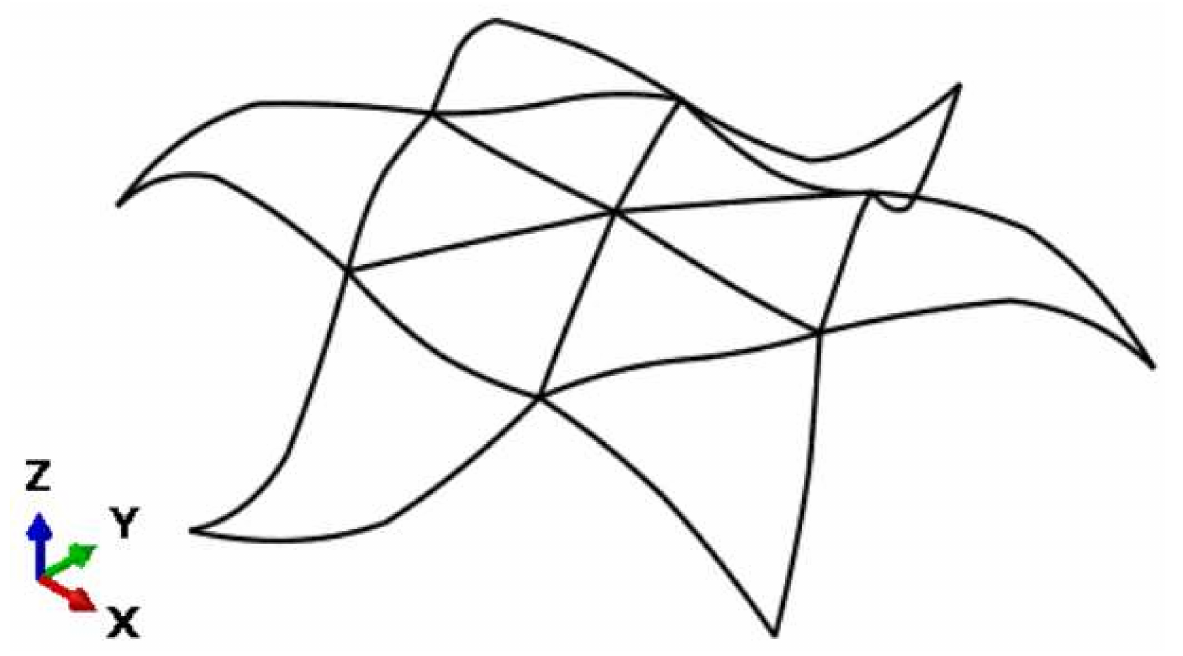
Figure 8. Dome 2—real part of the second nonlinear eigenvector.